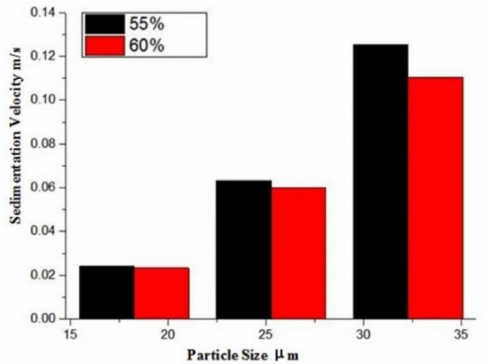
Figure 12. Results of simulation experiment.